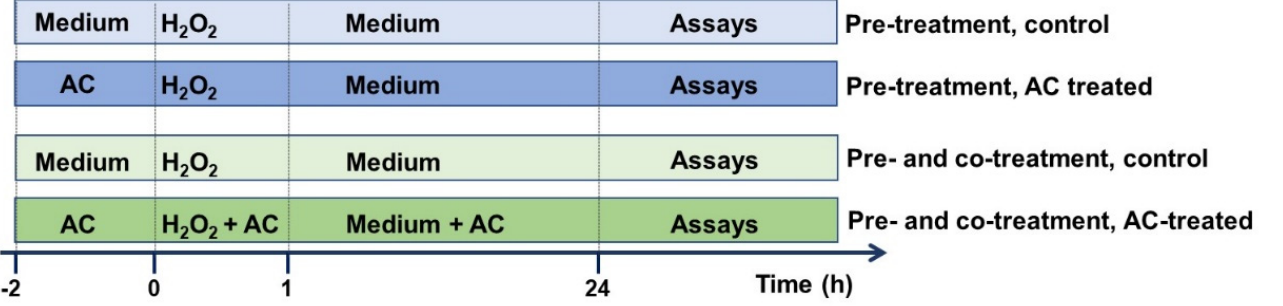
Figure 1. Neuroprotective effects of AC towards H 2 O 2 -induced injury in SH-SY5Y cells: experimental protocol used. To evaluate the potential of AC to prevent the injury, SH-SY5Y cells were treated with the extract (1–10 µg/mL) 2 h before (pre-treatment protocol) or 2 h before and during (pre- and co-treatment) cell injury (H 2 O 2 25 µM for 1 h, followed by 24 h with medium).